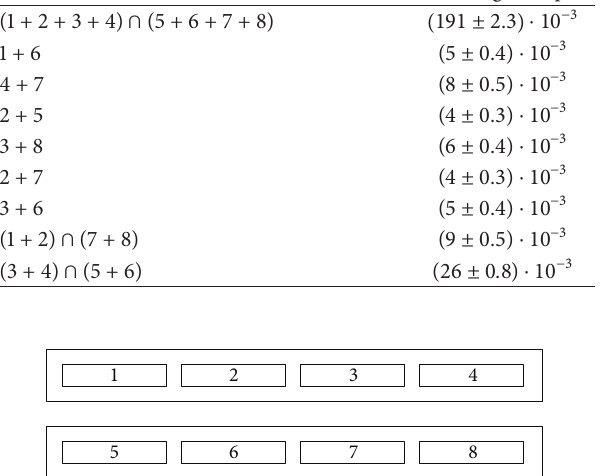
Figure 8: The orientation of the scintillator sheets of the new detector